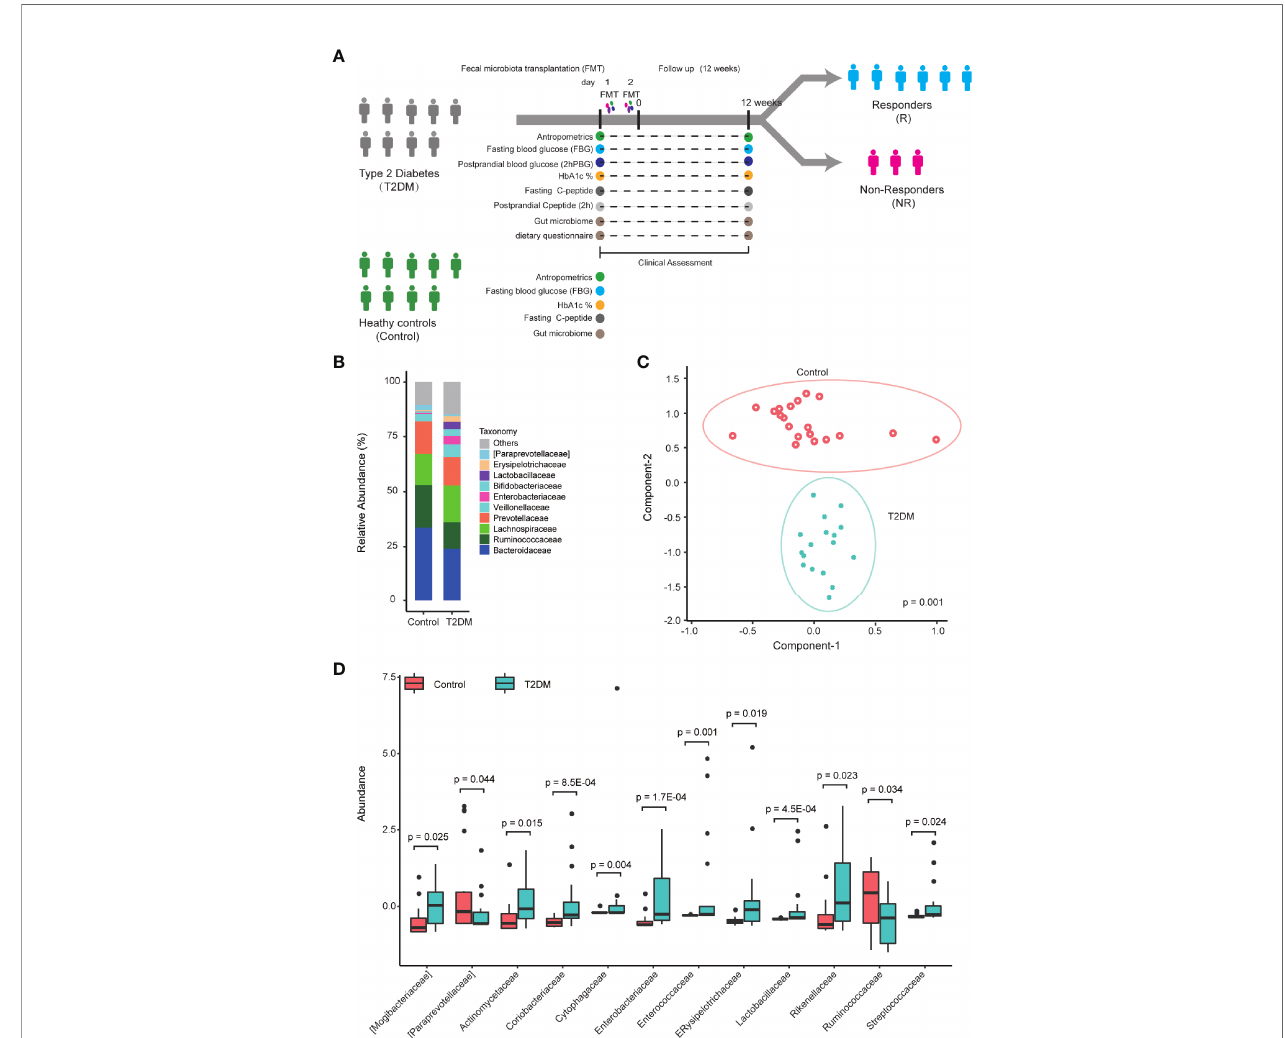
FIGURE 1 | The composition of fecal microbiome is altered in T2DM patients. (A) A graphic illustration of the perspective cohort study design to evaluate clinical outcomes in T2DM patients following FMT. (B) The relative abundance of the major microbial families in T2DM patients and controls. (C) Maximally collapsing metric learning (MCML) analysis of family-level T2DM gut microbiomes. Seventeen T2DM samples (green cross) and 20 control samples (res open circle). The p-value was obtained from permutational multivariate analysis of variance (PERMANOVA). (D) Boxplot of relative abundance of 12 families that showed the signi fi cant difference between T2DM and control. The p-values were obtained by Mann – Whitney test. Boxes represent the median and interquartile ranges between the fi rst and third quartiles. The dots represent